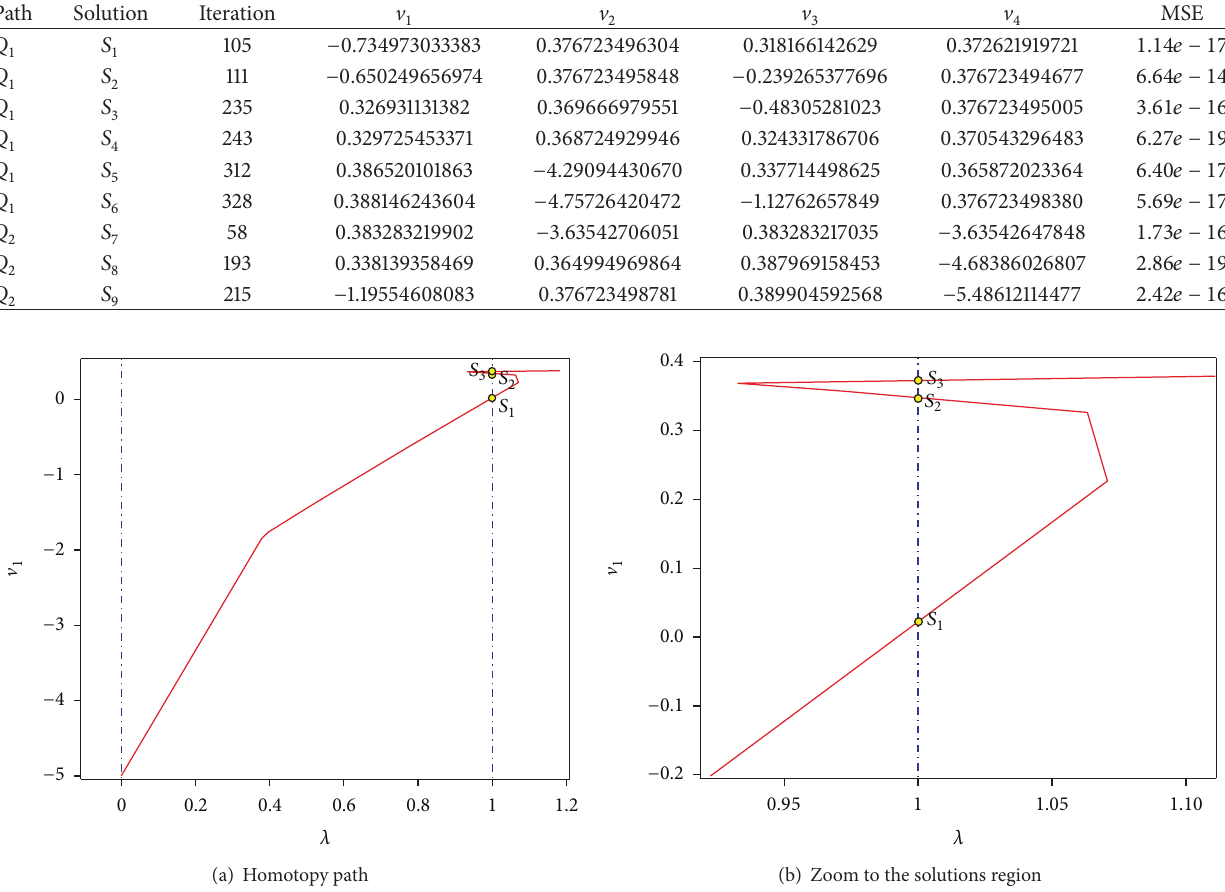
Table 4: Numerical solutions for (18).